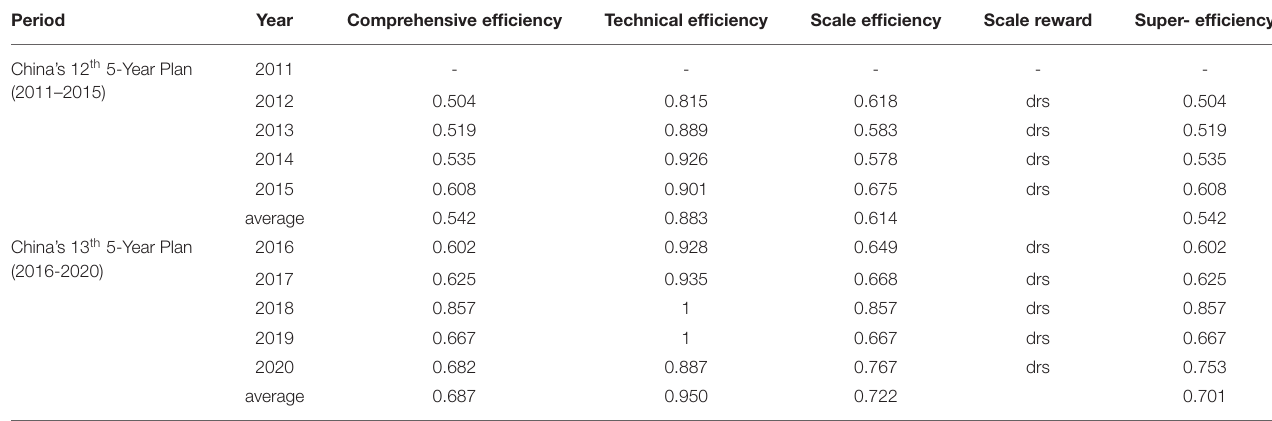
TABLE 2 | Efficiency of medical PPP projects from 2011 to 2020.